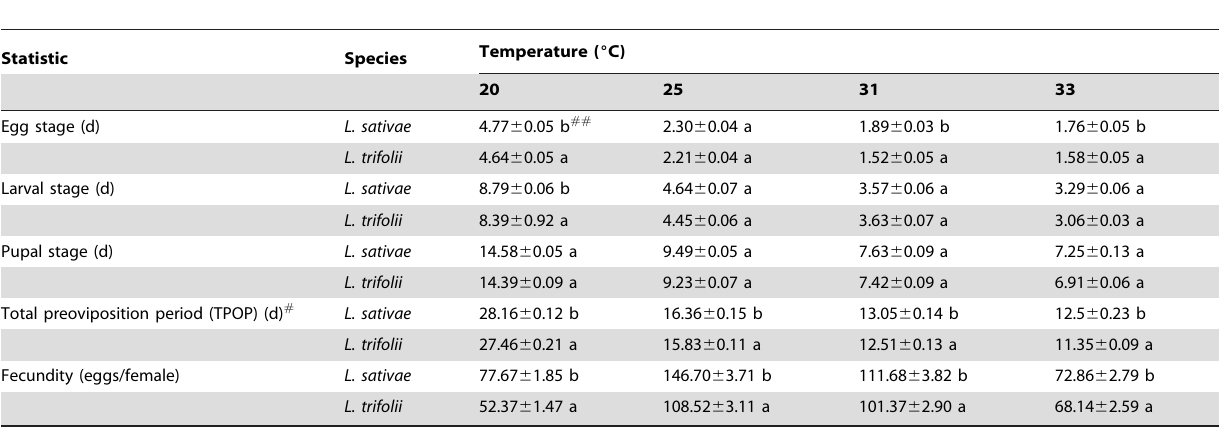
Table 1. Developmental duration of various life stages and female fecundity of L. trifolii and L. sativae when reared at different constant